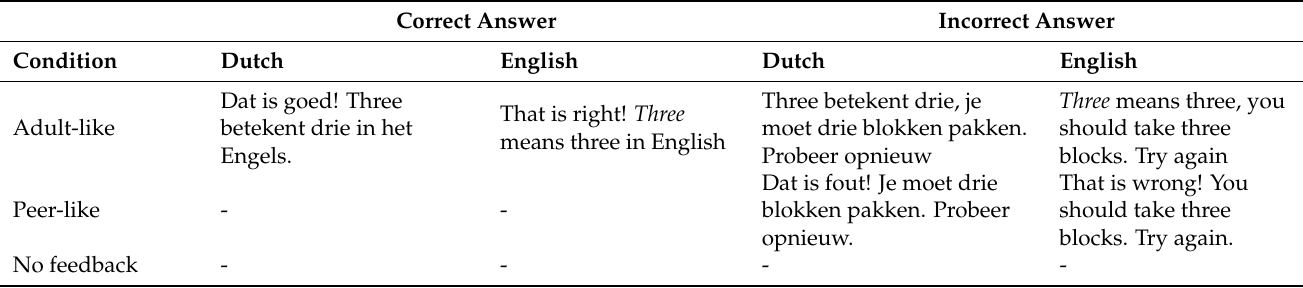
Table 1. An example of the robot’s feedback in the different feedback conditions.